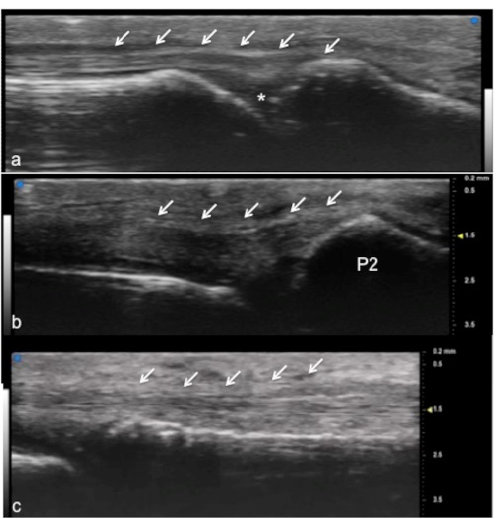
Figure 2. Extensor tendon of a finger. UHFUS gives a detailed and magnified representation of small structures such as the extensor tendon of the finger, even allowing the visualization of partial lesions. In ( a ), the sagittal view of the terminal extensor tendon (white arrows) at the level of the distal interphalangeal joint (white asterisk). In ( b ), the median band of the extensor tendon inserting at the level of the middle phalanx (P2). In ( c ), the thin sagittal band of the extensor tendon at the level of the metacarpal head.